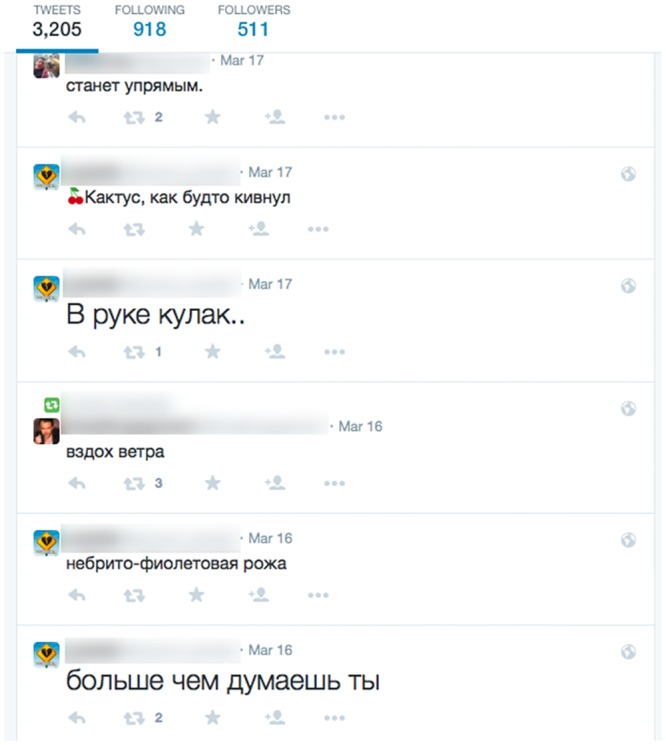
Example posts from one of the Russian bot accounts we detected.